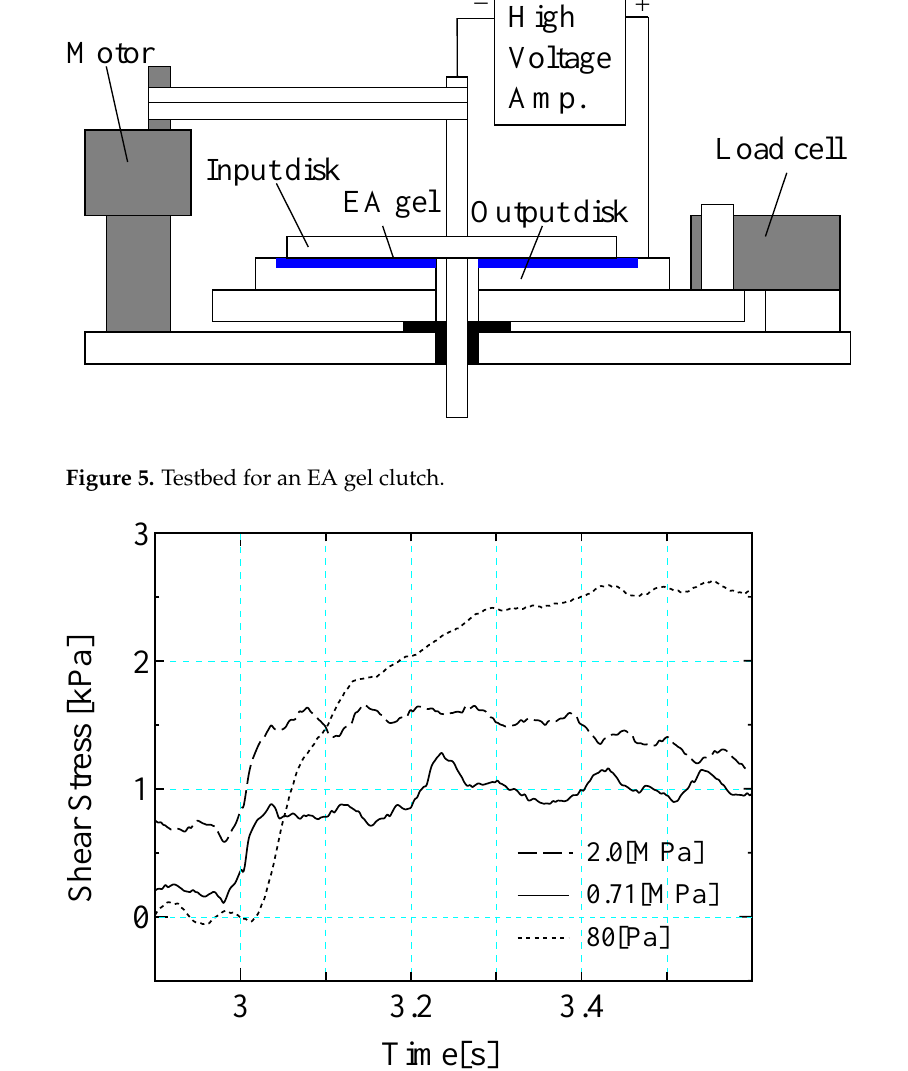
Figure 6. Comparing different pressures on an EA gel